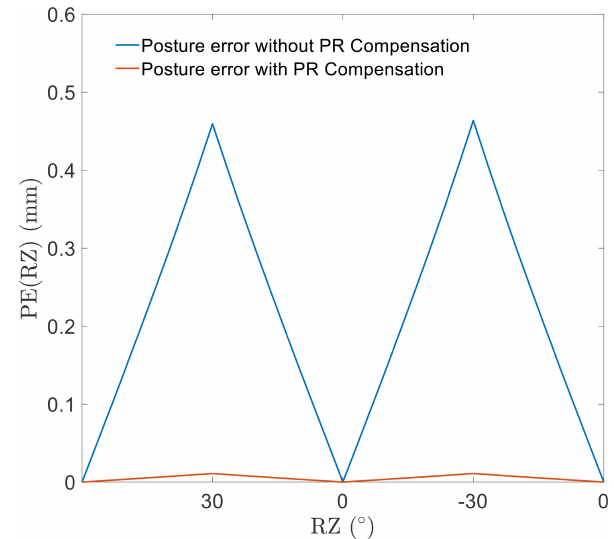
Figure 6. Comparison of posture errors in linear motion along z di- rection.